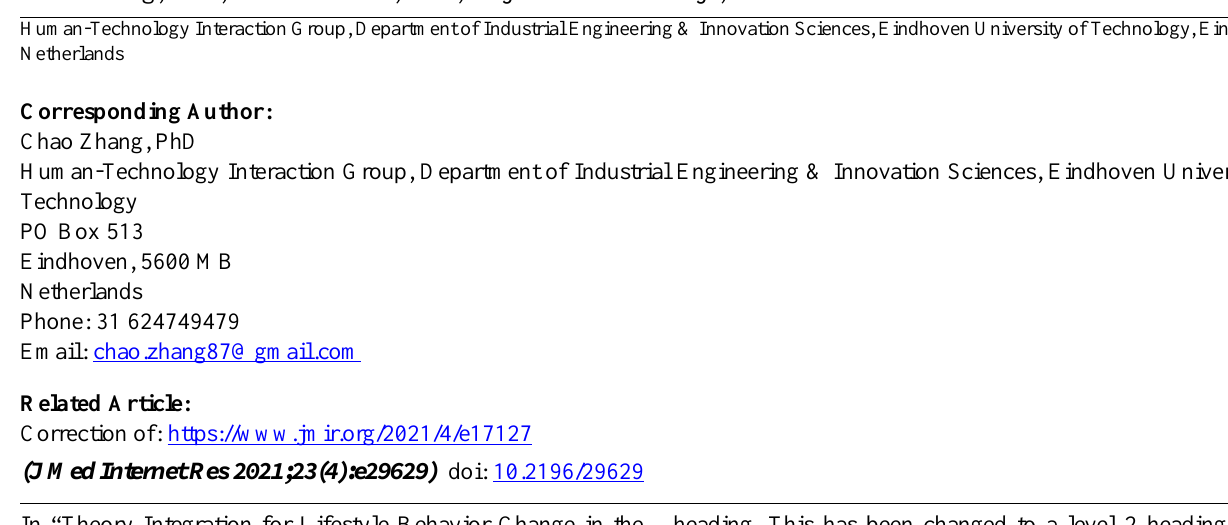
heading. This has been changed to a level 2 heading in the corrected version of the